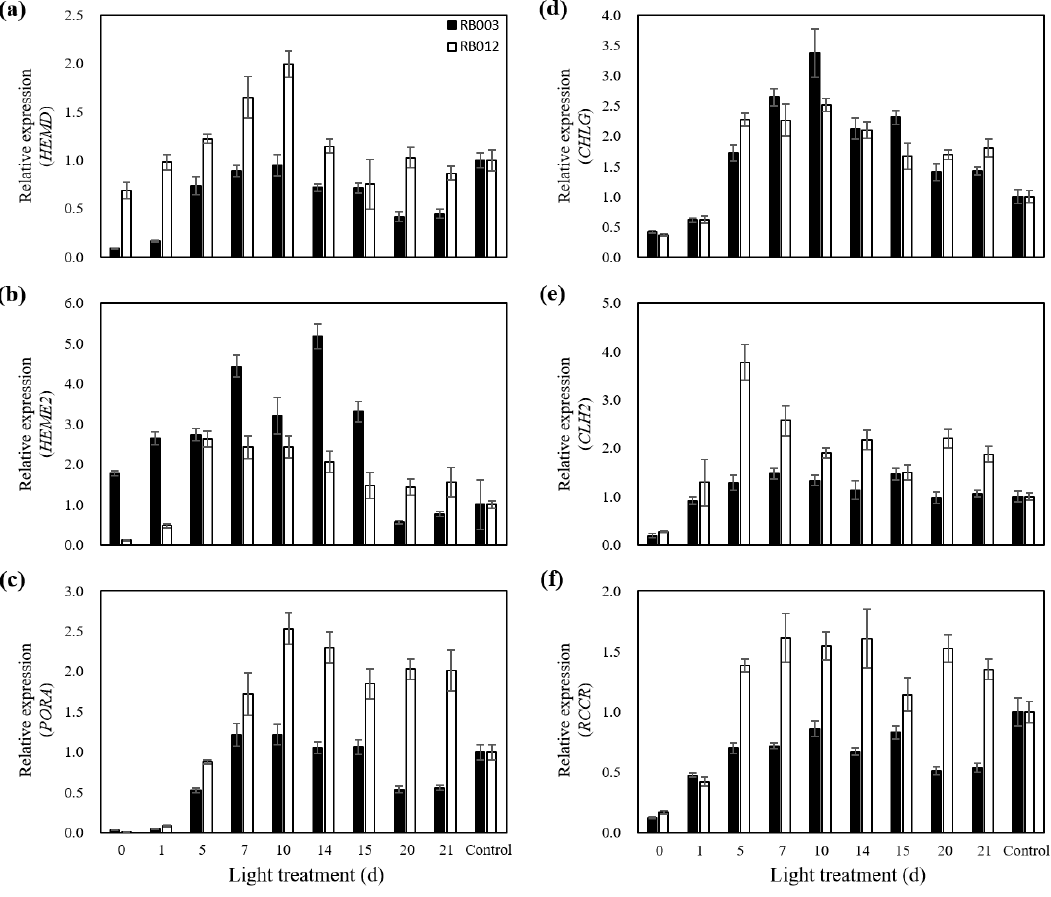
Figure 4. Relative expression of six genes involved in chlorophyll biosynthesis and degradation during light treatment of Cymbidium hybrids RB003 and RB012. ( a ) Relative expression of HEMD ; ( b ) Relative expression of HEME2 ; ( c ) Relative expression of PORA ; ( d ) Relative expression of CHLG ; ( e ) Relative expression of CLH2 ; ( f ) Relative expression of RCCR . Dark-treated rhizomes were subjected to light treatment. Dark treatment durations were 60 and 75 days for the rhizomes of Cymbidium hybrids RB003 and RB012, respectively.